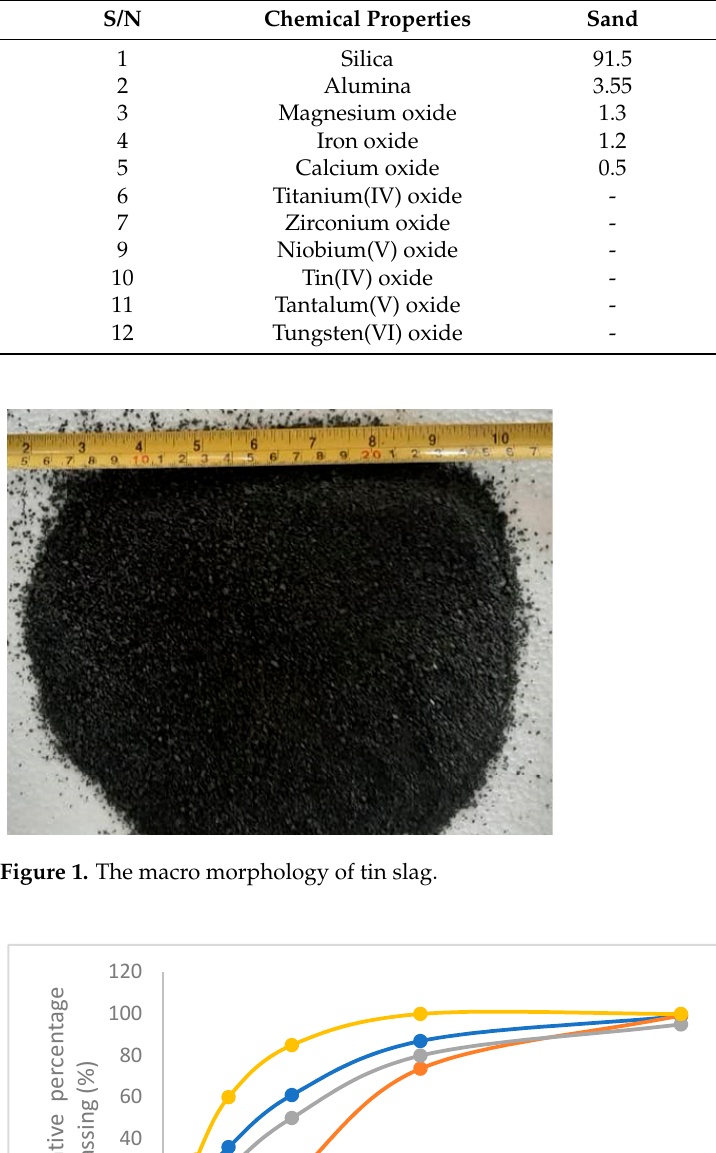
Figure 2. Initial sieve analysis.